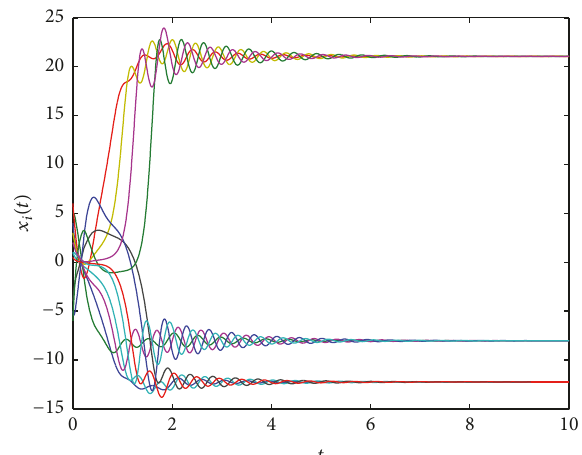
Figure 3: States of network (2) with control: 𝑥 𝑖 (𝑡), 𝑖 = 1, 2, 3,